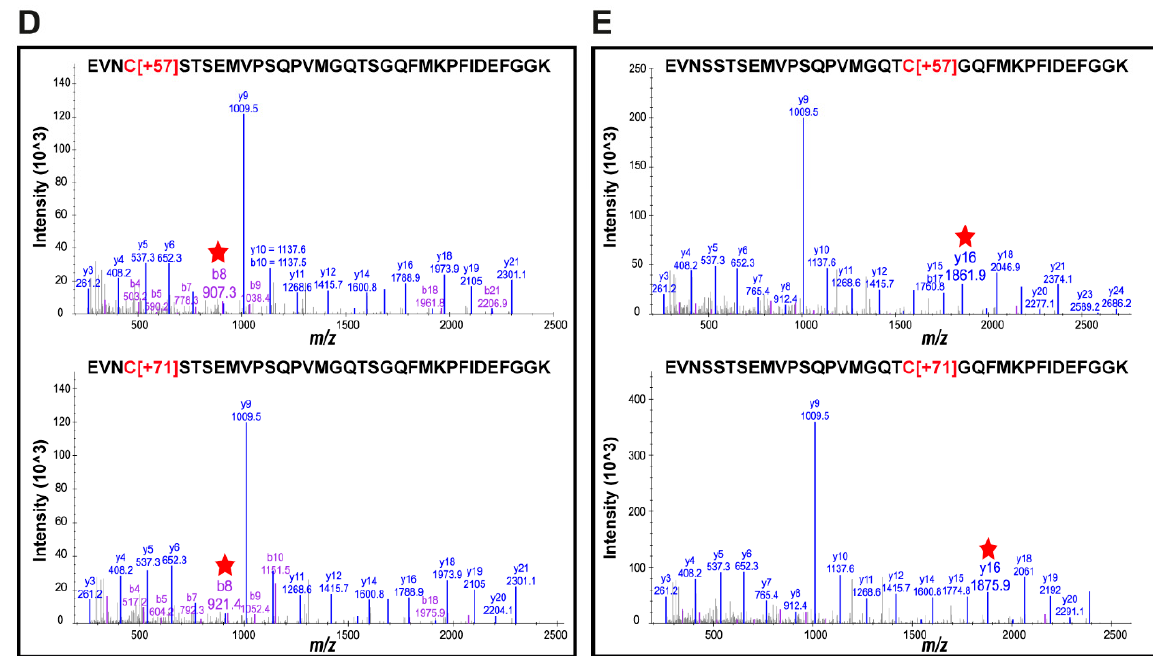
Figure 6. MS/MS spectra of peptide adducts obtained by a tryptic digest of Pdr11p. ( A ) Experimental flow chart for the chemical modification strategy and subsequent mass spectrometry-based identification of alkylated protein adducts. ( B – E ) Four cysteines ( B , C582; C , C603; D , C1290; E , C1306) were identified with two kinds of adducts, indicating their potential involvement in disulfide bonds. Red arrows indicate the representative product ions with 14-Da mass differences by comparing the upper and lower spectra of each peptide. Table 1. Percentage of acrylamide-reacted fraction for individual cysteines in ECL3 and ECL6